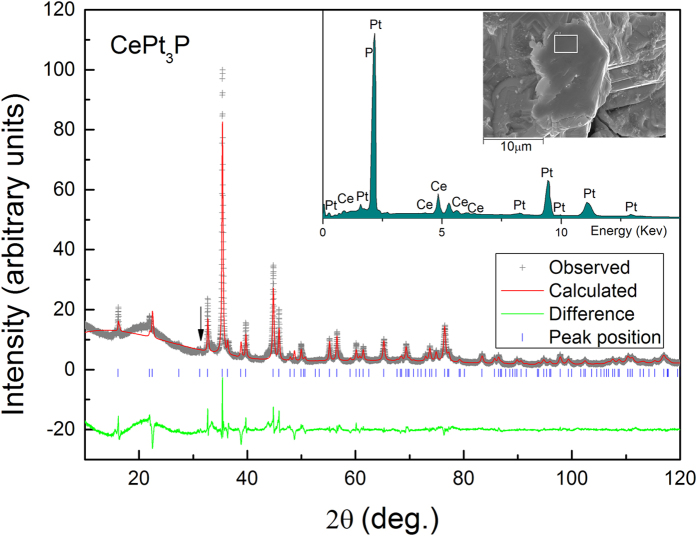
Rietveld refinement of the polycrystalline CePt3P XRD pattern.Arrow marks an impurity phase which might be PtP2. Inset shows a typical energy-dispersive x-ray spectrum with electron beams focused on the selected area of the as-grown sample.